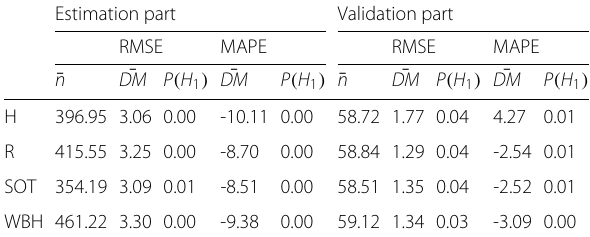
Table 1 Results for the Diebold-Mariano tests